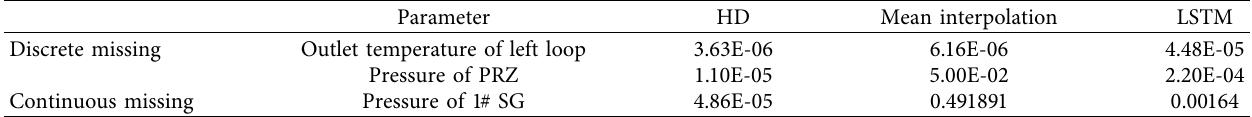
Table 6: Comparison of the average error rates.